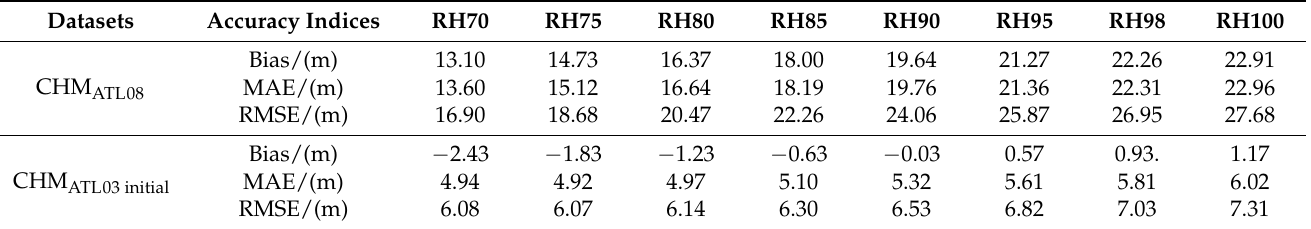
Table 5. Percentile canopy heights retrieved by different